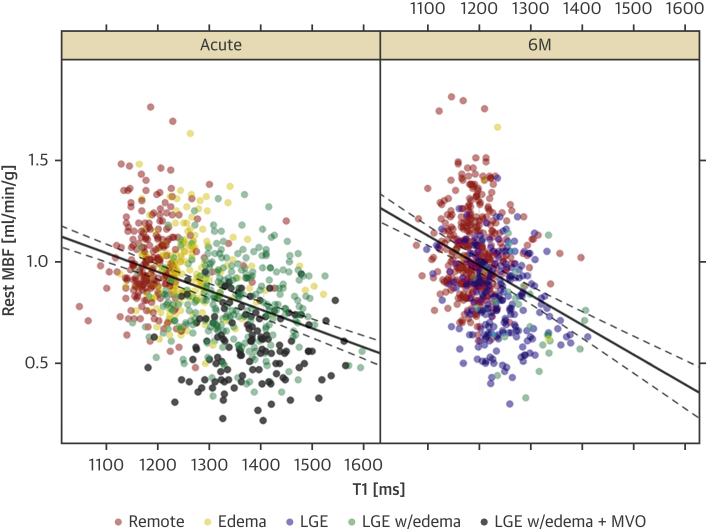
Relationship Between MBFcor and Native T1 Over 6MThe lines show the prediction from a linear mixed effects model for myocardial blood flow corrected (MBFcor), with native T1 and time point (with interaction term included) as predictors. The model included a random intercept by patient. The dashed lines show the 95th percentile ranges for the predictions from the linear mixed effects model. If regression coefficients for the effect of native T1 on myocardial blood flow are estimated for each tissue state, the association between myocardial blood flow and native T1 is significant only in the acute phase for late gadolinium enhancement with edema, and at 6 months (6M) for edema, late gadolinium enhancement (LGE), and late gadolinium enhancement with edema. MVO = microvascular obstruction.